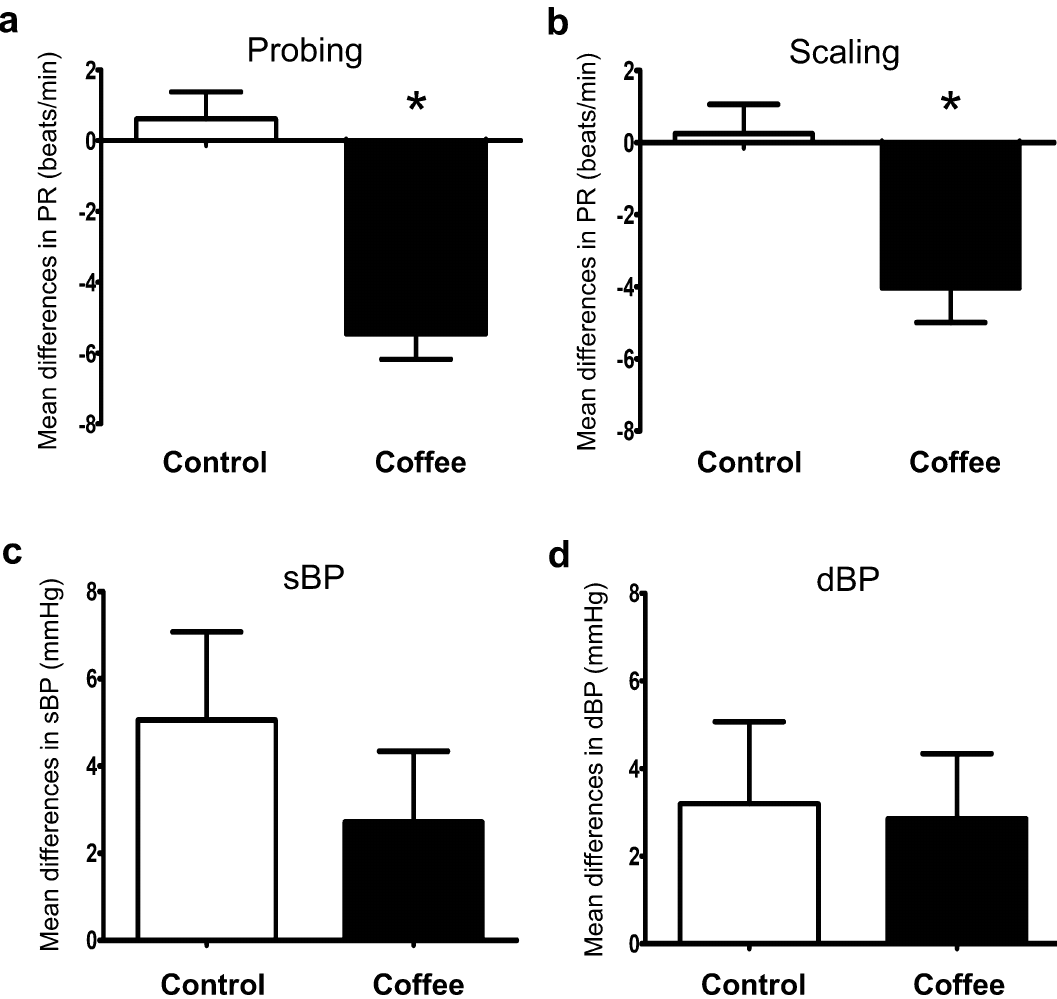
Figure 2. The mean differences in pulse rate after probing ( a ), scaling ( b ) and in systolic ( c ) and diastolic blood pressure ( d ) after probing and scaling in control and coffee inhaling groups. p <